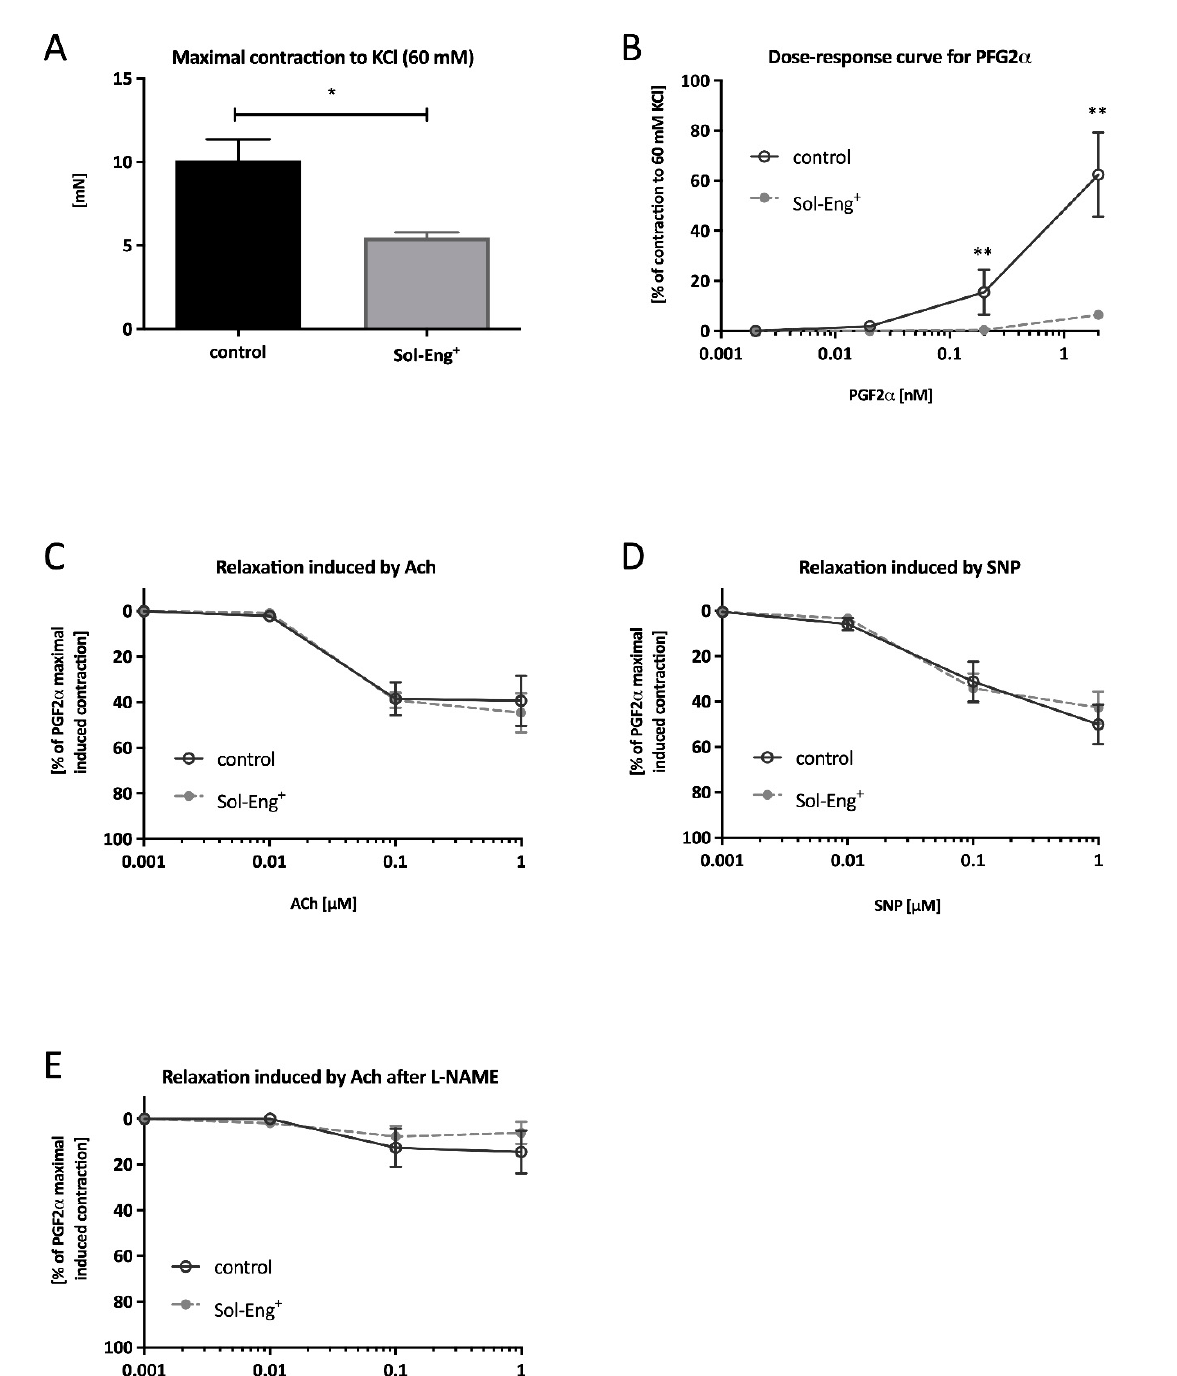
Figure 2. Functional analysis of vascular reactivity. A maximal contraction to KCl (60 mM) ( A ), dose–response curve to cumulative addition of PGF 2 α ( B ), dose–response curve to cumulative addition of Ach in pre-constricted aortic segments by PGF 2 α ( C ), dose–response curve to cumulative addition of SNP in pre-constricted aortic segments by PGF 2 α ( D ), dose–response curve to cumulative addition of Ach in pre-constricted aortic segments by PGF 2 α in the presence of L-NAME ( E ). Data are shown as a mean ± S.E.M., Mann–Whitney test, * p < 0.05, ** p ≤ 0.01. n = 6 mice per group. 3.3. High sEng Levels Do Not Affect the Expression of Biomarkers of Endothelial Dysfunction Biomarkers of endothelial dysfunction, namely vascular cell adhesion molecule 1 (VCAM-1) and intercellular adhesion molecule 1 (ICAM-1), were evaluated in the aorta.